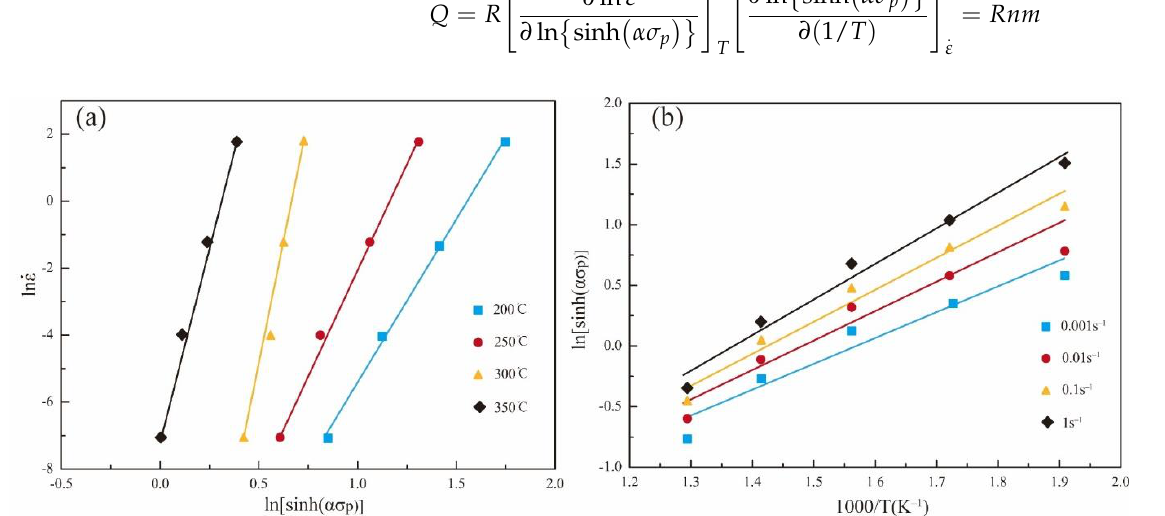
Figure 8. Relationship between flow stress and strain rate or temperature: ( a ) ln 𝜀̇ − ln[sinh( ασ p)] and ( b ) ln[sinh( ασ p)] − 1000/T.